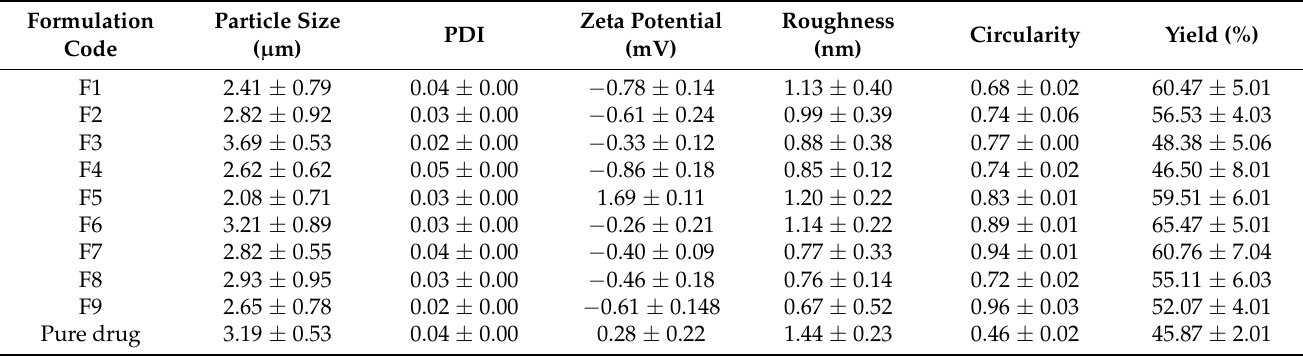
Table 2. Particle size, PDI, zeta potential and percentage yield of